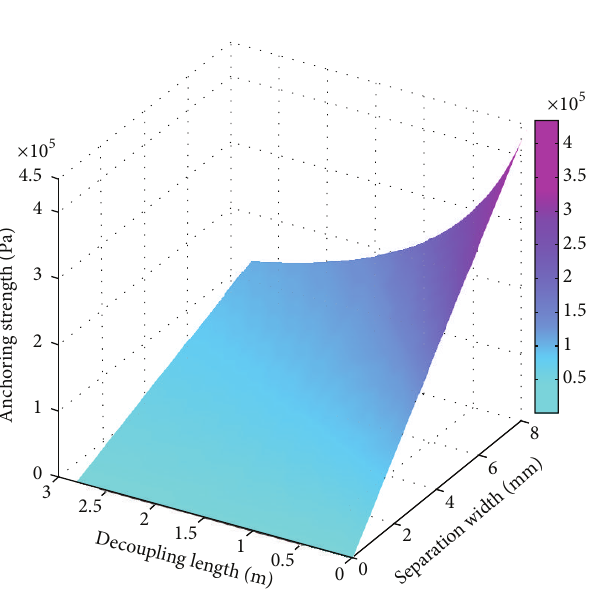
Figure 6: Relationship of the bolt support strength versus strata separation width and the bolt support strength versus decoupling length (the separation is located at the free loading